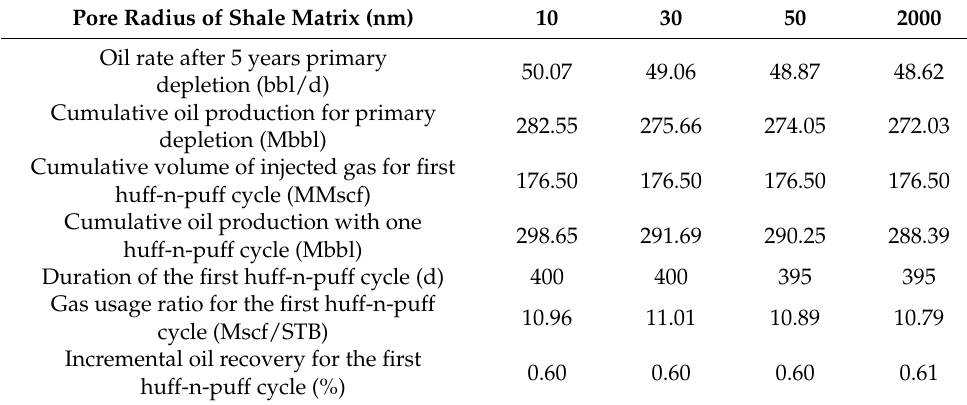
Table 9. Summary of results for huff-n-puff with different pore radius of shale matrix. Pore Radius of Shale Matrix